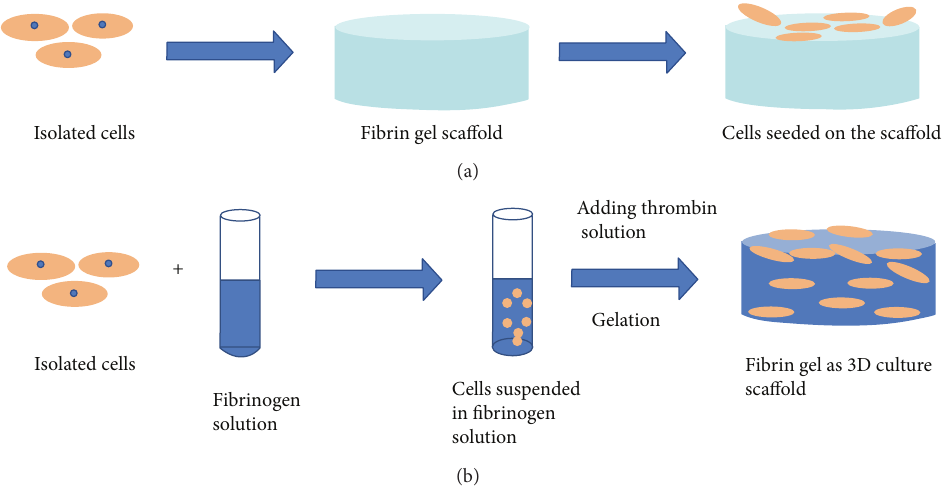
Figure3:Schematicillustrationoffabricationsoftwo-andthree-dimensionalcellculturescaffold.Theconventionaltwo-dimensionalscaffold is fabricated in advance of cell seeding and the isolated cells are seeded on the surface of scaffold (a). The three-dimensional scaffold cures in the presence of the encapsulated cells. Then, the mixture can be delivered into a mold to gel or directly injected into a defect in the body (b).